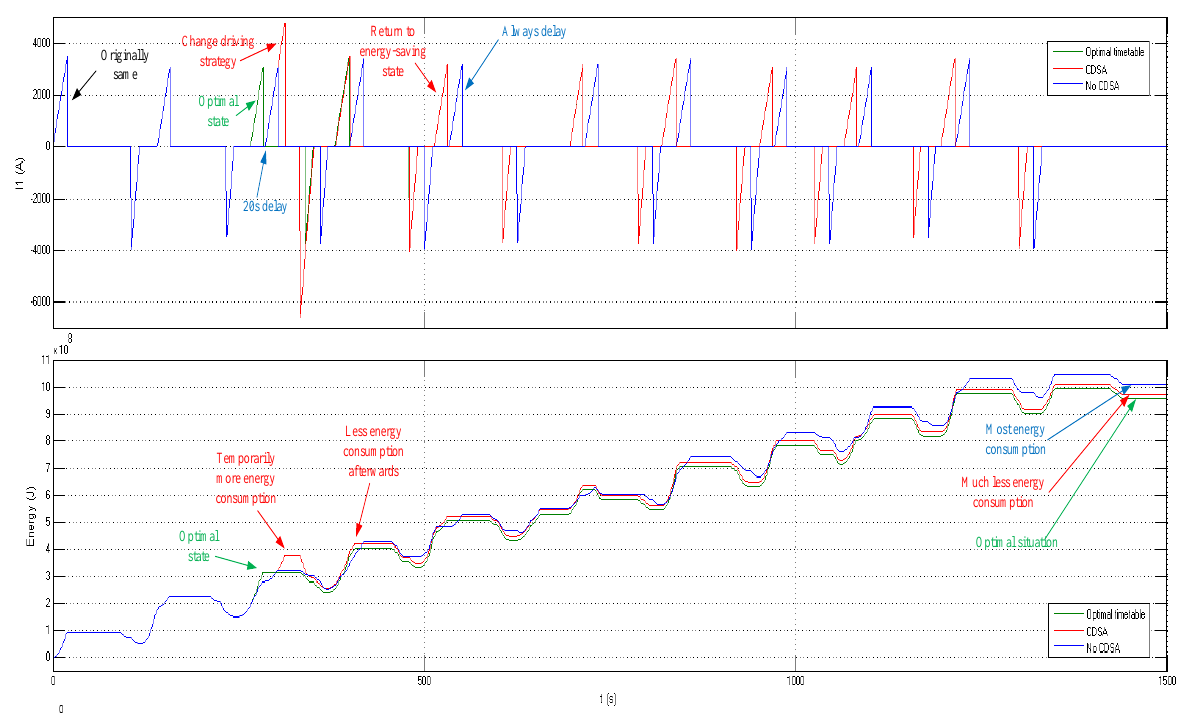
Figure 13. Current curves and the corresponding energy consumption curve.